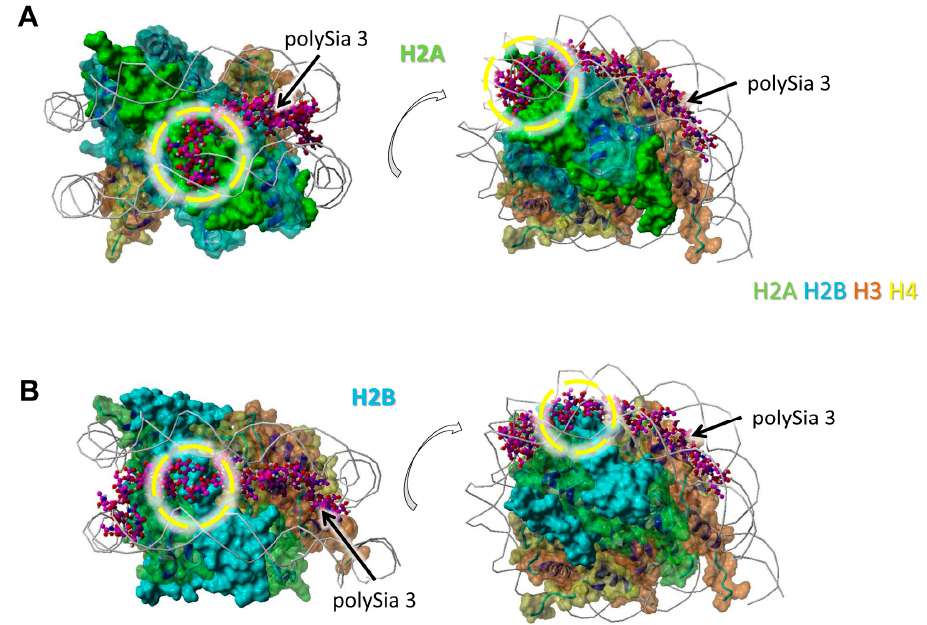
Figure 2. Model of interaction between polySia and H2A as well as H2B. The model was generated as described in Figure 1. Color-code: H2A—green, H2B—cyan, H3—orange, H4—yellow, polySia—purple, DNA—gray (as cords). Potential binding areas are highlighted by dashed circles for the histones; ( A ) Histone H2A, ( B ) Histone H2B. The numbered polySia chains are indicated by arrows. Both models are shown from two different perspectives (rotated, as shown by the open